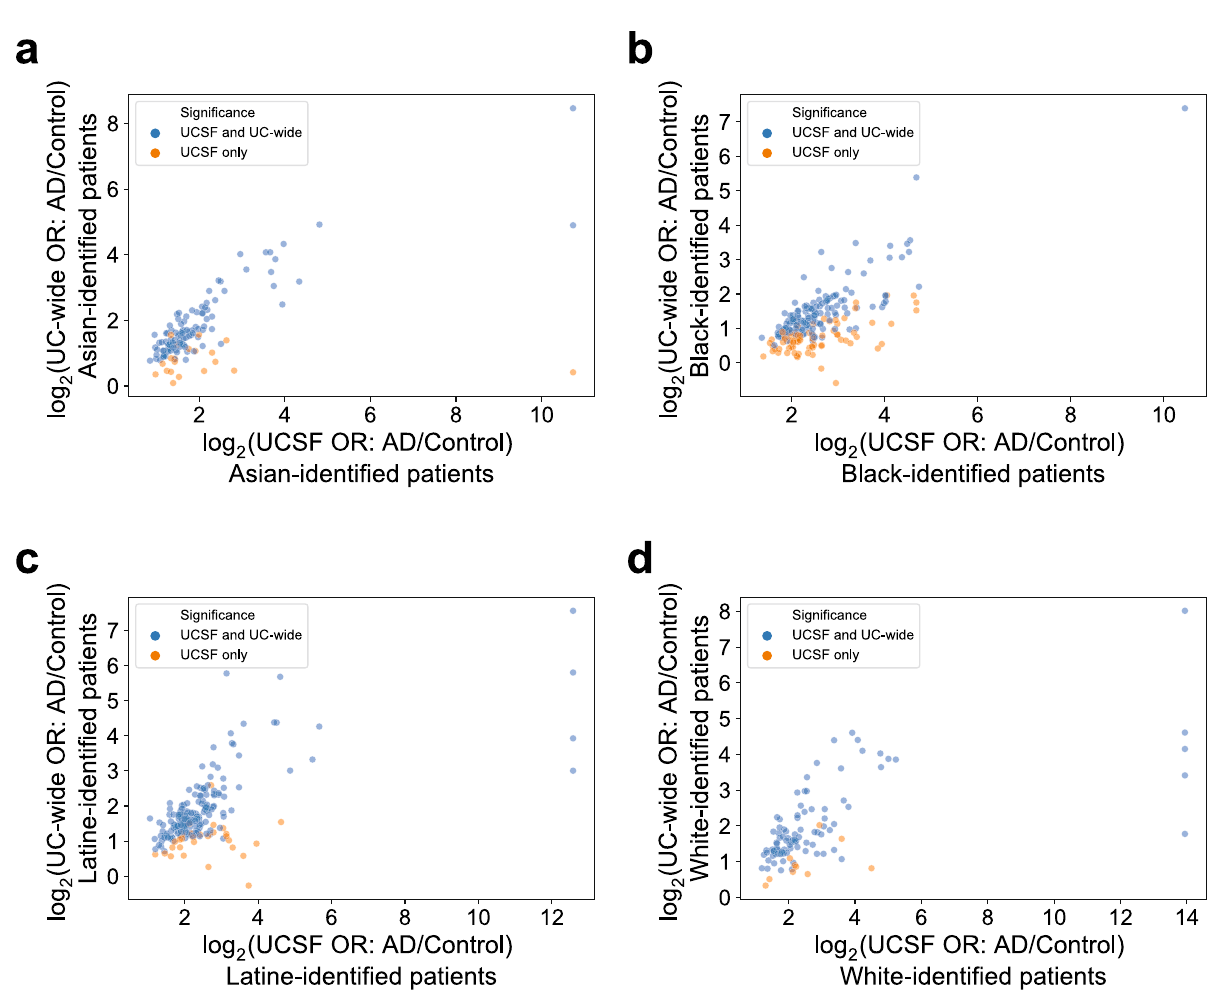
Fig. 5 Signi fi cant AD-associated comorbidities at UCSF that are also signi fi cant in the UC-wide validation cohort are signi fi cantly correlated. AD versus control log-log odds ratio correlation plots of phenotypes for ( a ) Asian-, ( b ) Black-, ( c ) Latine-, and ( d ) White- identi fi ed patients with AD between UCSF and UC-wide. Comorbidities (represented as phecode-corresponding phenotypes) shown are signi fi cant at UCSF (two-sided Fisher ’ s exact or chi- squared tests, Bonferroni-corrected p -value < 0.05). Each dot represents a comorbidity. Dots in blue represent comorbidities signi fi cant both at UCSF and in the UC-wide validation cohort, while dots in orange represent comorbidities signi fi cant at UCSF only. AD Alzheimer ’ s dementia, OR Odds ratio, UCSF University of California San Francisco. For Asian-identi fi ed patients ( a ), 102 phenotypes were signi fi cant at both UCSF and UC-wide, while 20 were signi fi cant only at UCSF. For Black-identi fi ed patients ( b ), 138 phenotypes were signi fi cant at both UCSF and UC-wide, while 75 were signi fi cant only at UCSF. For Latine-identi fi ed patients ( c ), 168 phenotypes were signi fi cant at both UCSF and UC-wide, while 30 were signi fi cant only at UCSF. For White- identi fi ed patients ( d ), 90 phenotypes were signi fi cant at both UCSF and UC-wide, while 10 were signi fi cant only at UCSF. For each racialized population, n = 422 patients with AD at UCSF; n = 844 control patients at UCSF; n = 994 patients with AD in the UC-wide validation cohort; n = 1988 control patients in the UC-wide validation